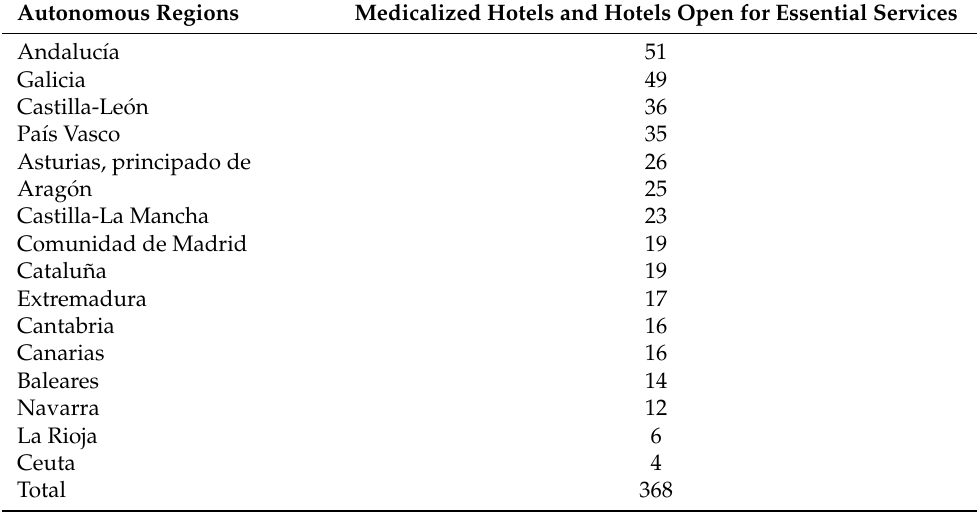
Table 4. Medicalized hotels and hotels open for essential services distributed amongst au- tonomous